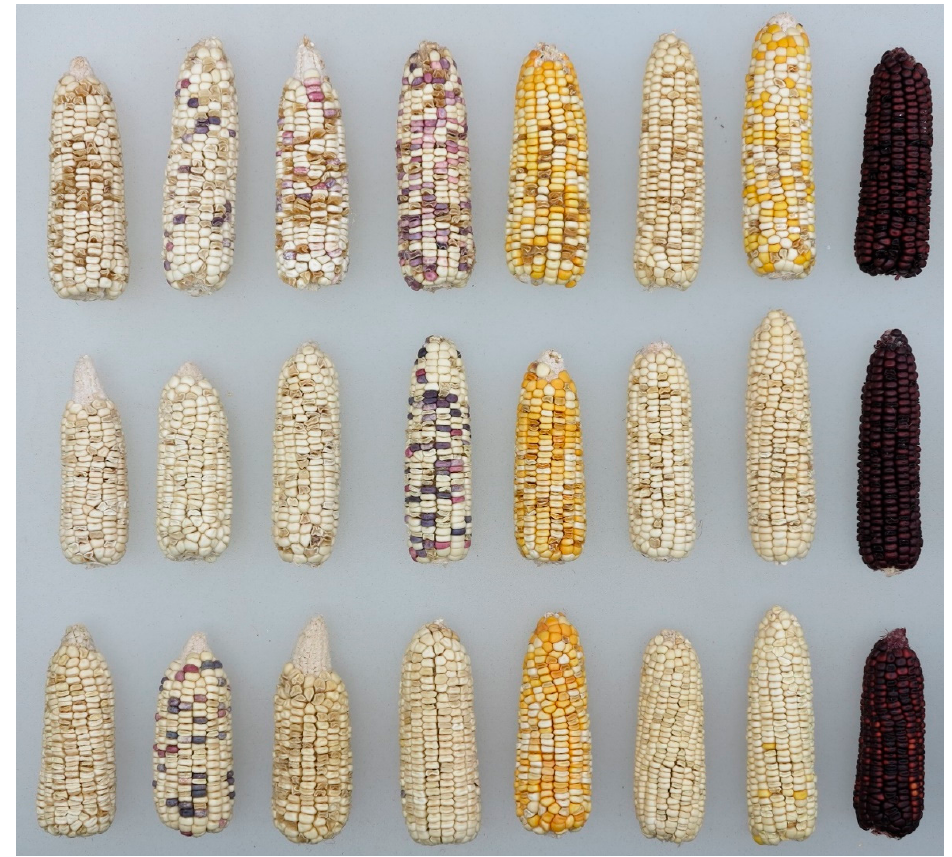
Figure 1. Ear appearances of 24 sweet-waxy corn hybrids excluding reciprocals at physiological maturity stage. maturity